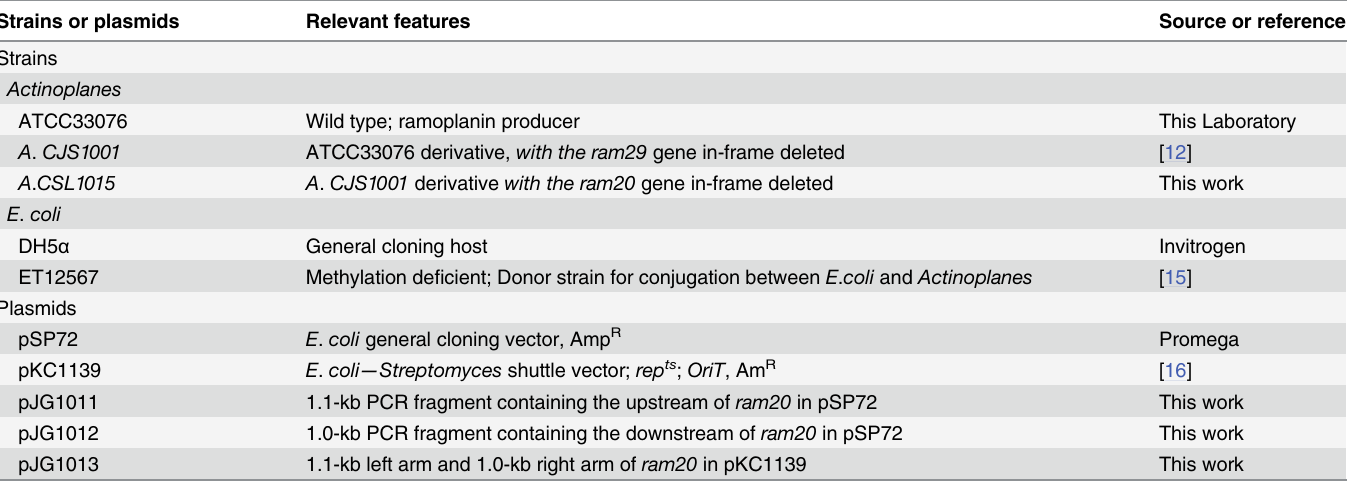
Table 1. Strains and plasmids used in this